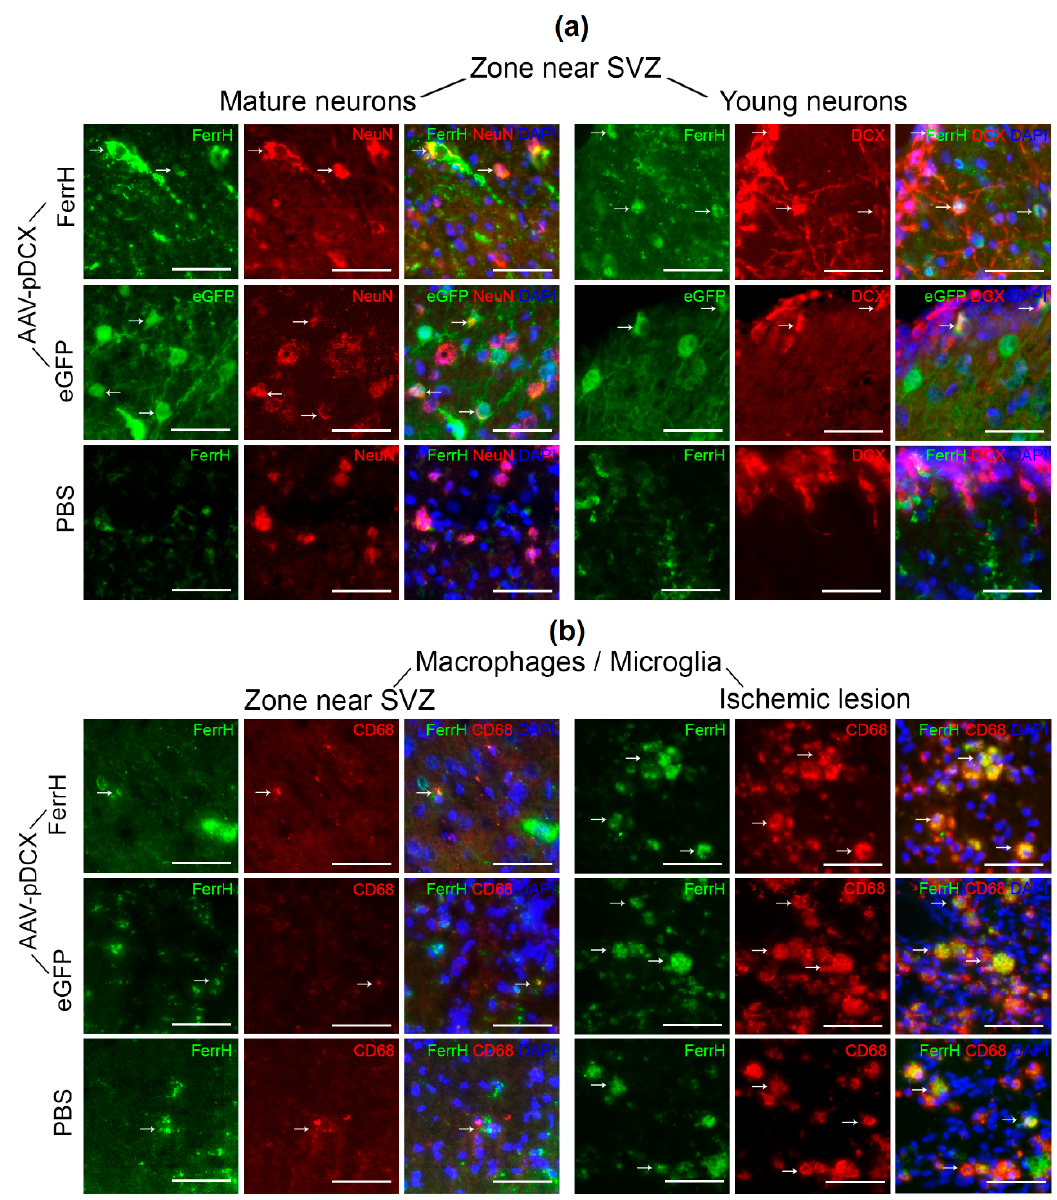
Figure 7. Examples of immunofluorescent staining for FerrH, NeuN (mature neurons), DCX (young neurons), and activated microglia \ macrophages (CD68). ( a ) Double-immunofluorescence images stained for mature (FerrH \ NeuN for the Ferr-MCAO and PBS-MCAO group, eGFP \ NeuN for the eGFP-MCAO group), young (FerrH \ DCX for the FerrH-MCAO and PBS-MCAO group, and eGFP \ DCX for the eGFP-MCAO group) neurons in the zone near the lateral ventricle and SVZ. ( b ) Double-immunofluorescence images stained for microglia \ macrophages (FerrH \ CD68) in the near lateral ventricle and SVZ (left three rows) and inside the ischemic lesion (right three rows). For eGFP-MCAO group, FerrH is visualized by far-red fluorochrome and is shown as green pseudo color. Scale bars corresponds to 50 µm. Abbreviations: MCAO, middle-cerebral-artery occlusion; AAV, adeno-associated viral backbone; pDCX, doublecortin promoter; FerrH, ferritin heavy chain; eGFP, enhanced green fluorescent protein; PBS, phosphate-buffered saline; SVZ, subventricular zone. Quantification of FerrH / NeuN, FerrH / DCX, eGFP / NeuN, and eGFP \ DCX double-positive cells is shown on the Figure 8. The number of ferritin-expressing mature neurons was higher than the number of young neurons in both the FerrH-MCAO and FerrH-Sham groups (statistically significant only for the FerrH-Sham group, p = 0.03). A similar tendency was observed in the groups with the AAV-pDCX-eGFP administration—the number of mature neurons was statistically-significantly